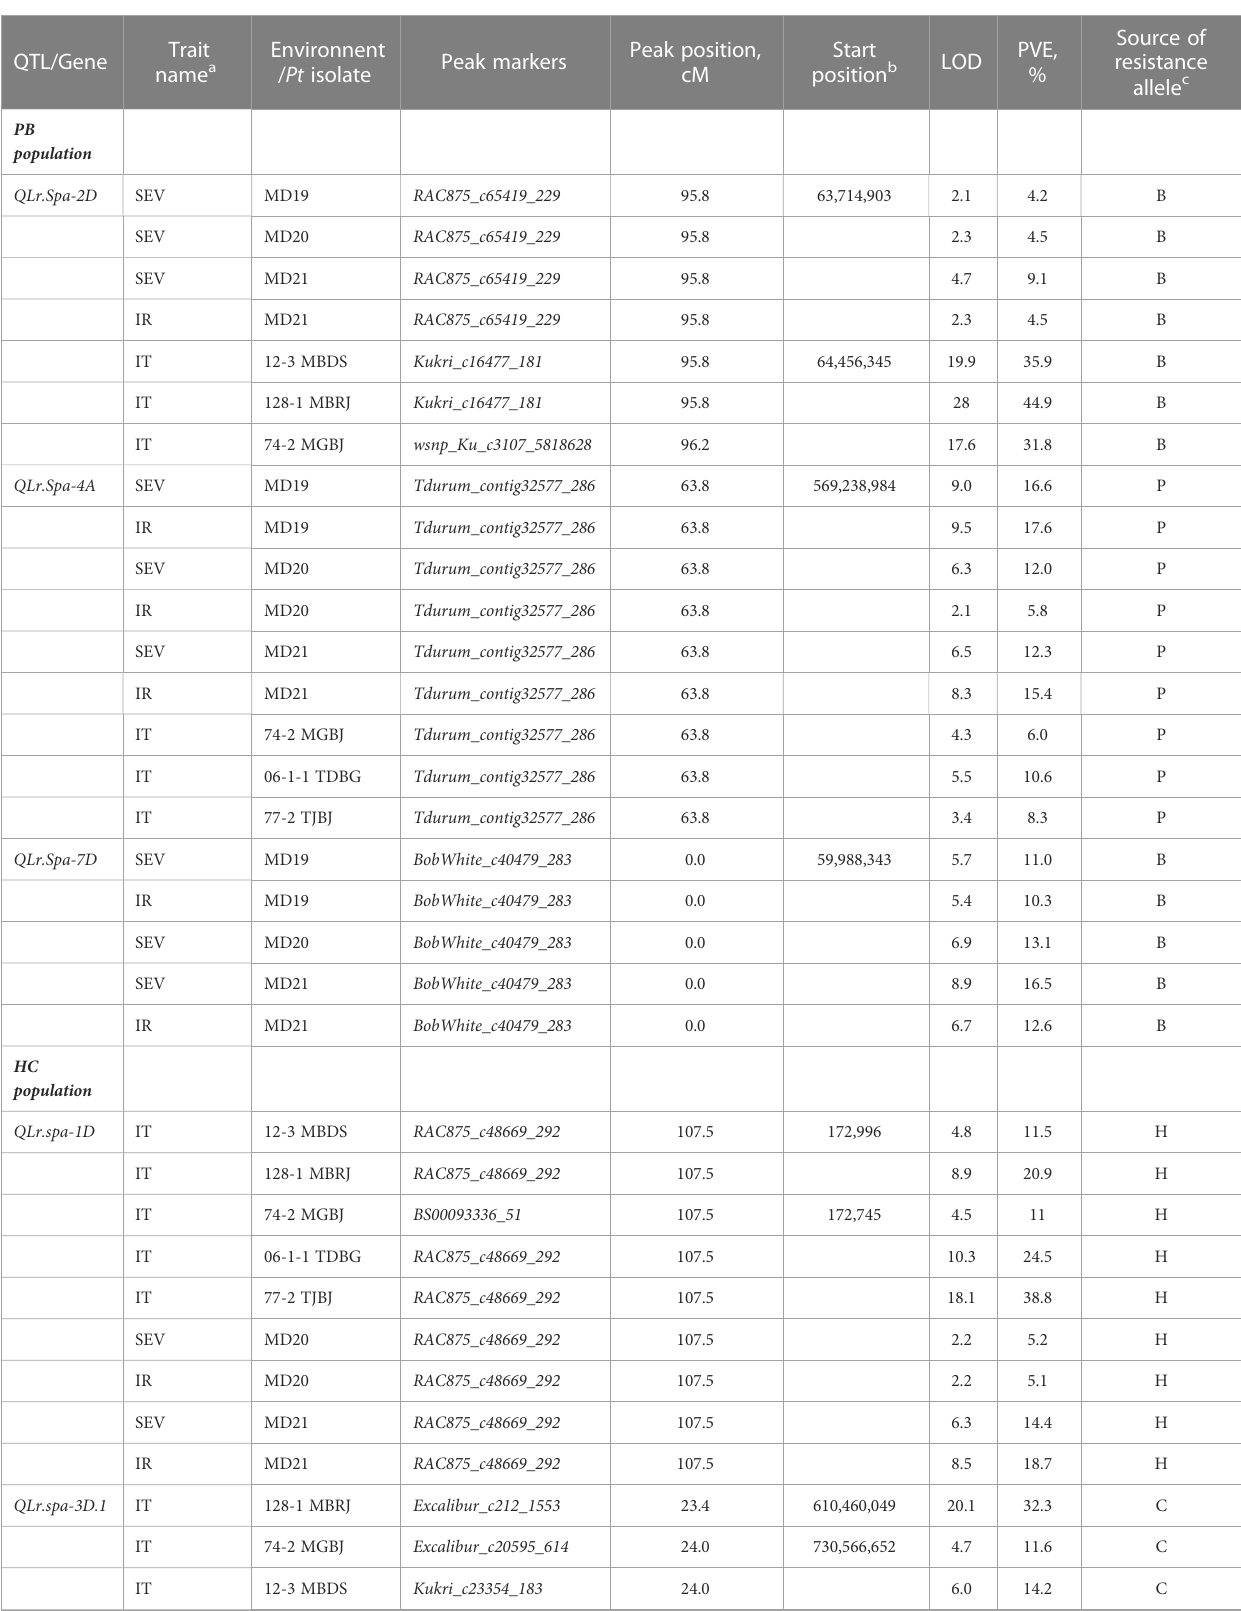
TABLE 3 Leaf rust resistance QTL identi fi ed in the AAC Prevail (P)/BW961 (B), CDC Hughes (H)/AC Concord (C), and Lillian (L)/Glenlea (G) doubled haploid populations evaluated for seedling plant leaf rust infection response to isolates 12-3 MBDS, 128-1 MBRJ, 74-2 MGBJ, 77-2 TJBJ, 06-1-1 TDBG, 21-21-1 TNBJ, and adult plant disease response in nurseries located in Morden (MD), Manitoba in 2019, 2020, and